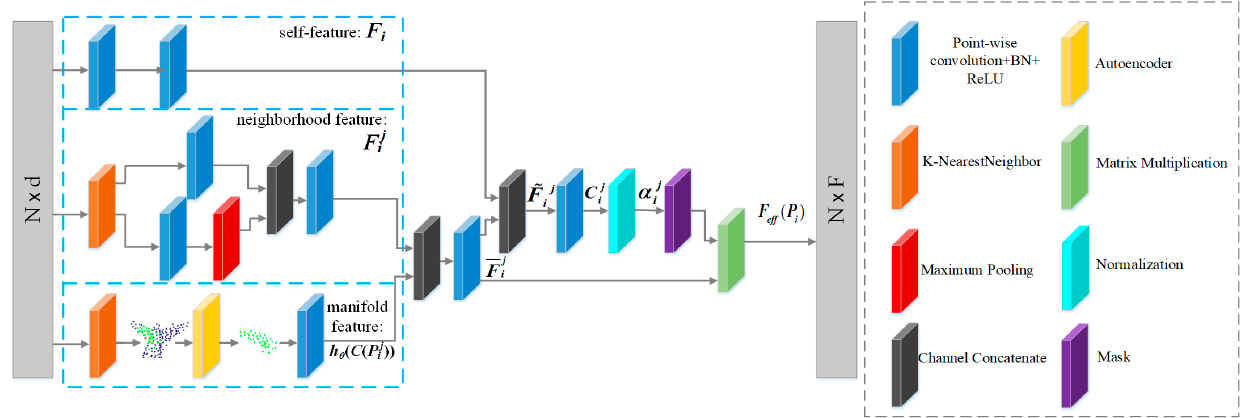
Figure 5. Single-head structure.